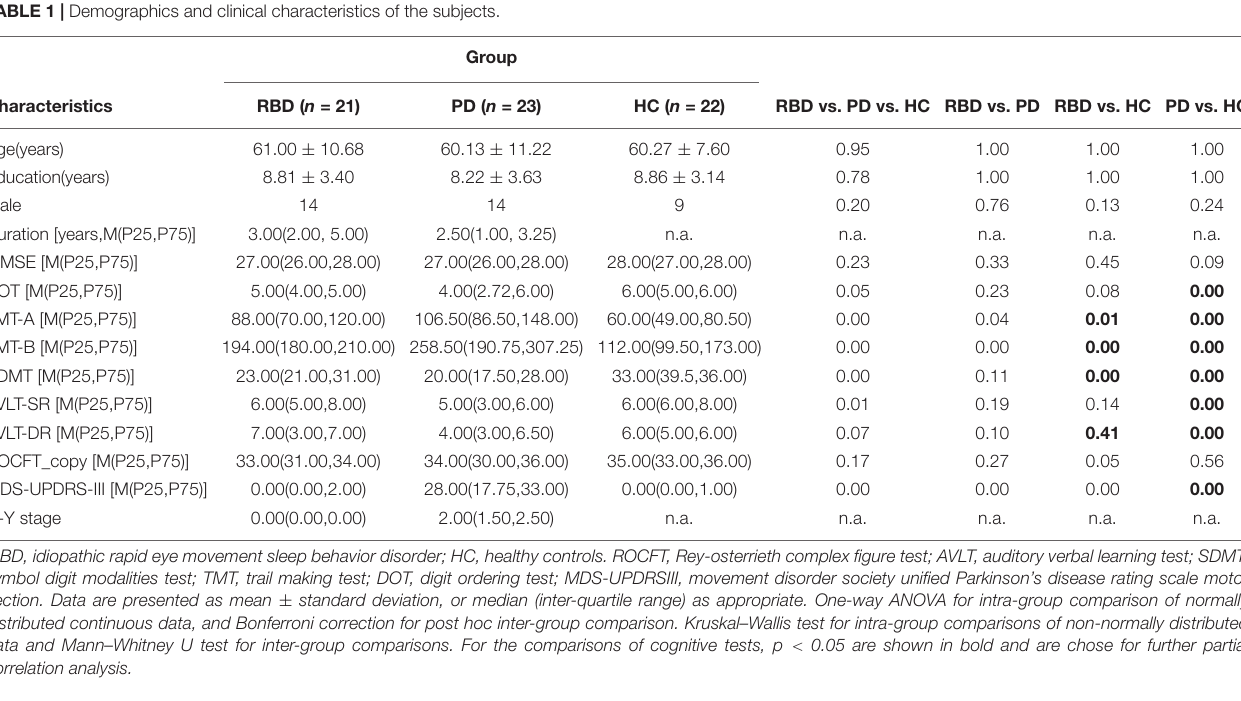
TABLE 1 | Demographics and clinical characteristics of the subjects.